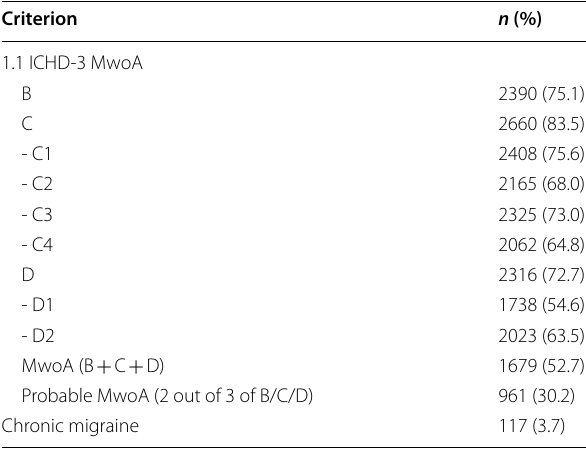
Table 1 Participants meeting ICHD‑3 diagnostic criteria for